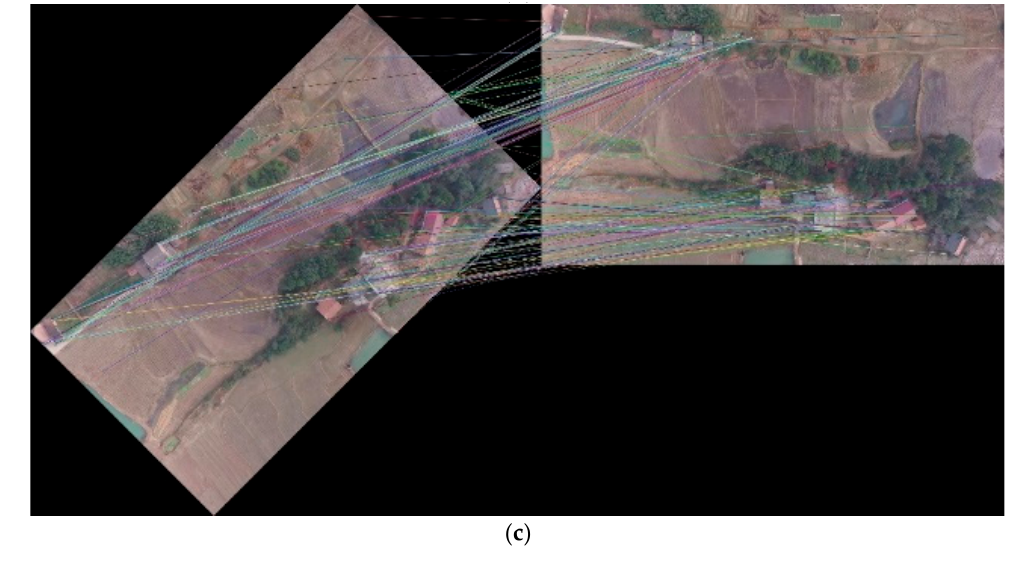
Figure 10. The matching of the original image with its rotated image using: ( a ) SIFT feature extraction algorithm ( b ) SURF feature extraction algorithm ( c ) ORB feature extraction algorithm. Table 5. Results of comparing the image with its rotated image. The best result is marked in bold. Feature Extraction Algorithm